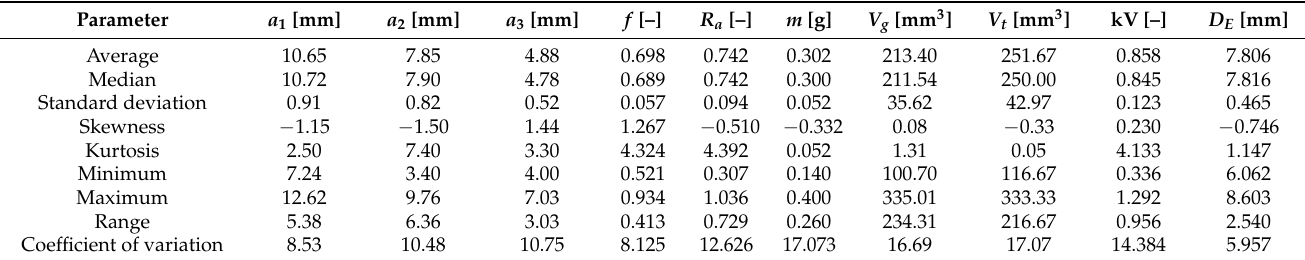
Table 3. Results of statistical analysis of the examined selected physical properties of corn grains. Parameter